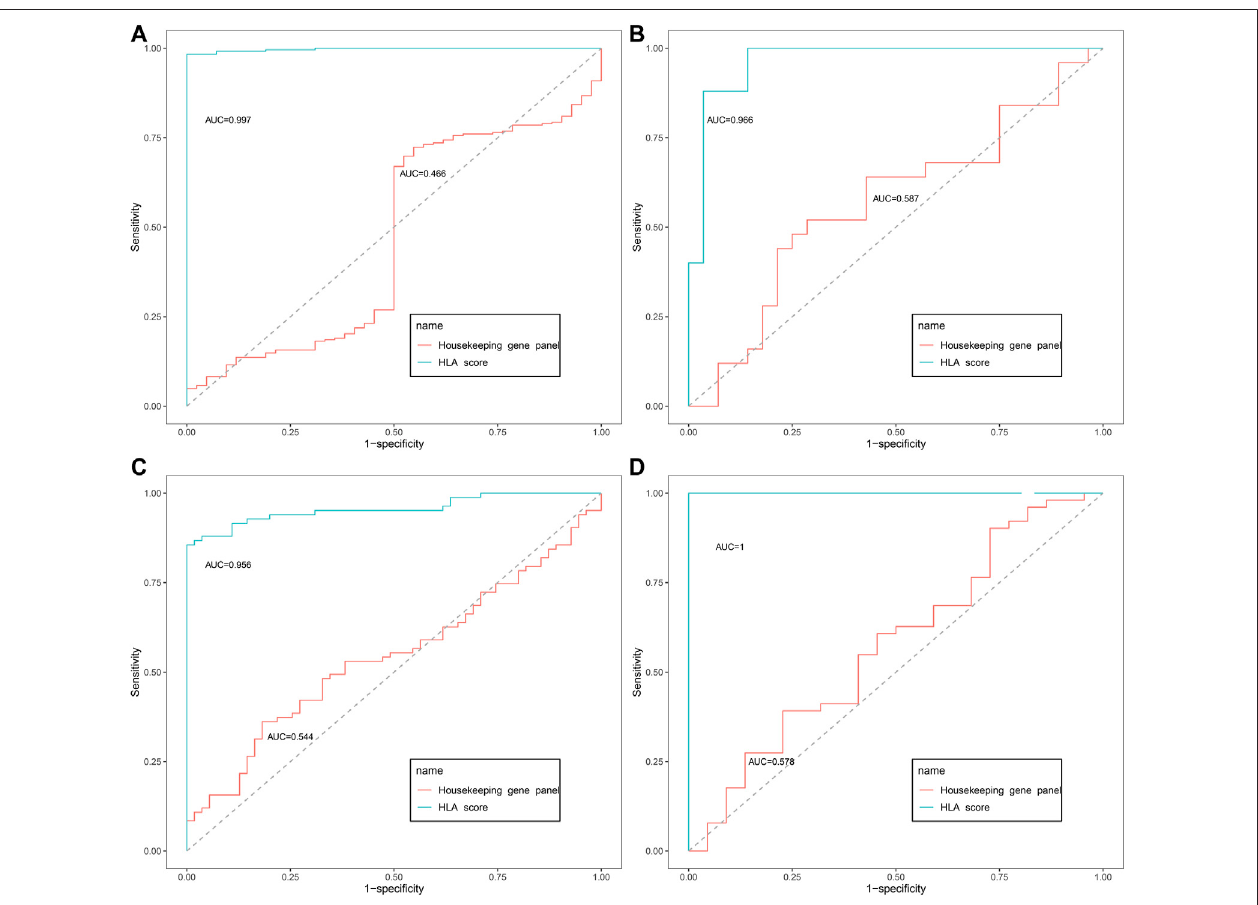
FIGURE 2 | The diagnostic ef fi cacy of the HLA classi fi er in the discovery cohorts. (A) GSE65682 datasets. (B) GSE57065 datasets. (C) GSE69528 datasets. (D) GSE95233